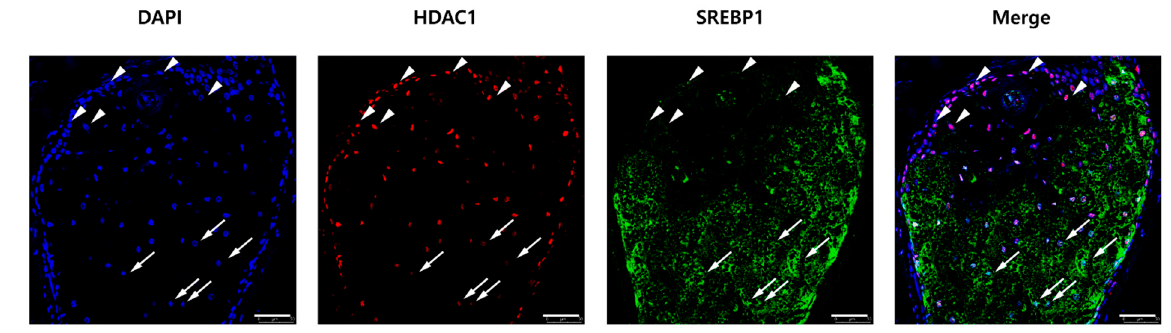
Figure 6. Histone deacetylase 1 (HDAC1) and sterol regulatory element binding protein 1 (SREBP1) expression levels were inversely correlated in normal human sebocytes. Sebaceous glands in normal human skin tissues were subjected to double immunofluorescence staining for HDAC1 (red) and SREBP1 (green). Arrows show sebocytes with low HDAC1 and high SREBP1, whereas arrowheads show sebocytes with high HDAC1 and low SREBP1. Nuclei were counterstained with DAPI. Scale bar = 50 µm; ×300 magnification.